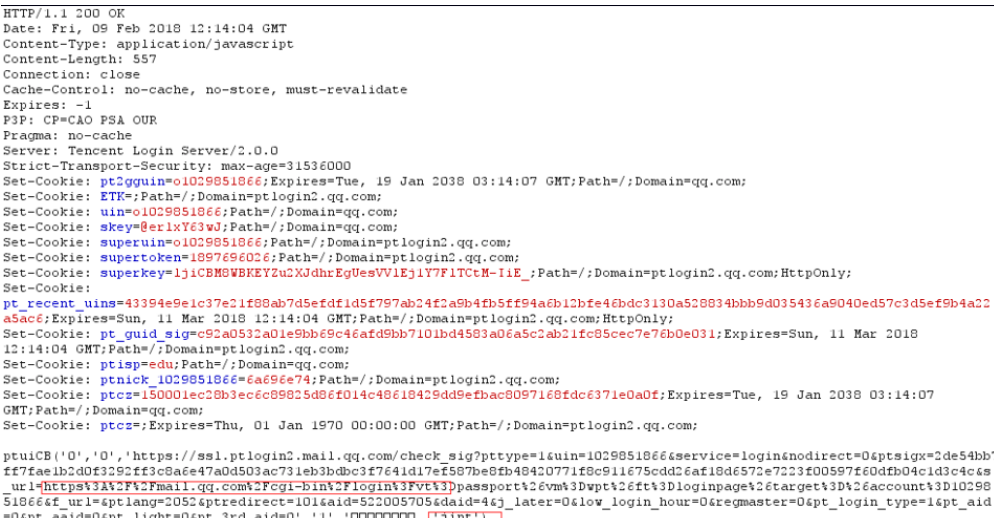
Figure 29. Intercepted response message.